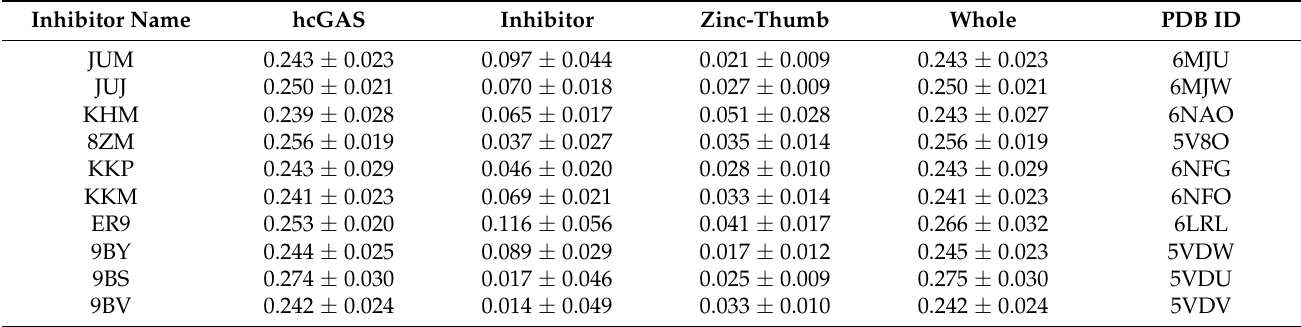
Table 1. Averaged root mean square deviation (RMSD) (nm) evaluations for hcGAS, inhibitor, zinc-thumb domain, and whole structures in 10 hcGAS-inhibitor